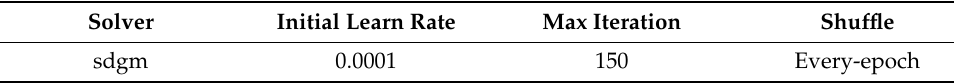
Figure 1. Proposed architecture of the network. Table 1. Training settings of the Table 1. Training settings of the CNN.